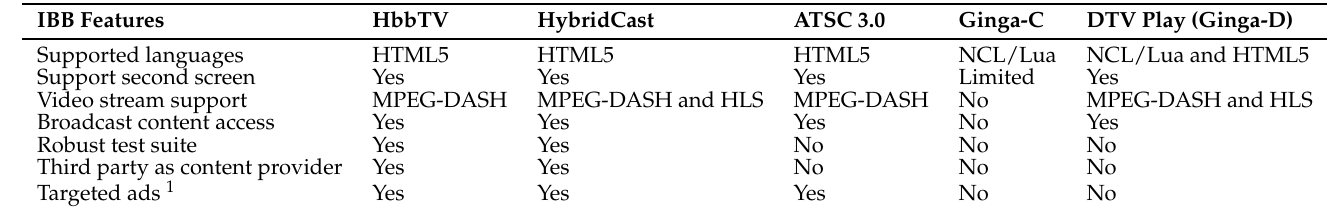
Table 2. IBB interactive supported